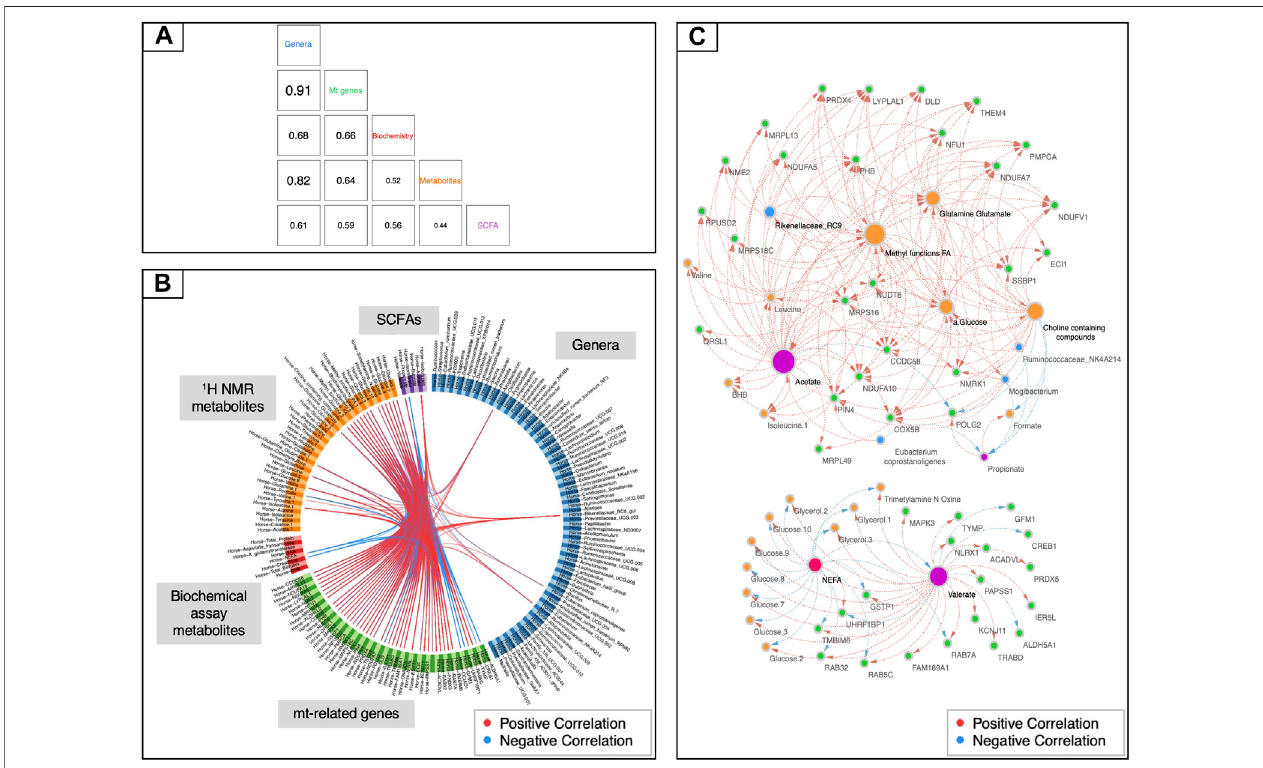
FIGURE 4 | Data integration using mt-related genes, 1 H NMR metabolites, biochemical assay metabolites, fecal SCFAs and gut bacteria. (A) Matrix scatterplot showing the correlation between the fi rst components related to each dataset in DIABLO according to the input design. (B) CIRCOS plot of the fi nal multi-omics fi nal signature. Each dataset is given a different colour: mt-related genes are in green, 1 H NMR metabolites in orange, biochemical assay metabolites in red, fecal SCFAs in violetandgutbacteriaindarkblue.Redandbluelinesindicatepositiveandnegativecorrelationsbetweentwovariables, respectively( r ≥ |0.70|). (C) Visualizationof the network obtained with Cytoscape using the fi nal DIABLO multi-omics signature as an input. Only features with more than 15 connections are shown. The size of the nodes indicates the number of interacting partners within the network.